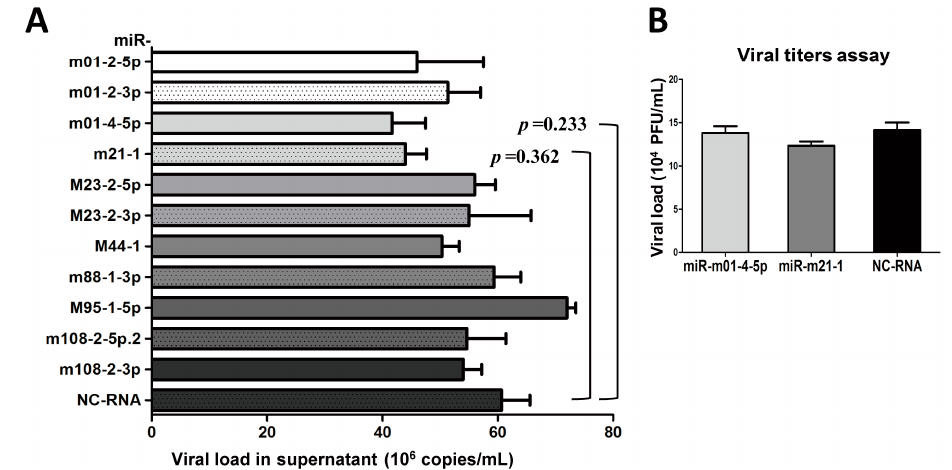
Figure 3. The inhibition of Group 1 viral miRNAs exerts minimal effects on viral production. ( A ) MEF cells were cultured in 24-well plates and transiently transfected with specific inhibitors of miRNAs from Group 1 or negative control RNA (NC-RNA). After 72 h of MCMV infection, viral copies were quantified by qPCR. ( B ) Two inhibitors of representative miRNAs (miR-m01-4-5p and miR-m21-1) were further examined using TCID 50 (50% tissue culture infective dose) assays. The results are shown as the mean ± SD. The assays were performed in triplicate wells, and data were confirmed in three independent experiments. p < 0.05 for viral miRNA-transfected versus NC-RNA-treated MEFs. PFU: Plaque-forming unit.